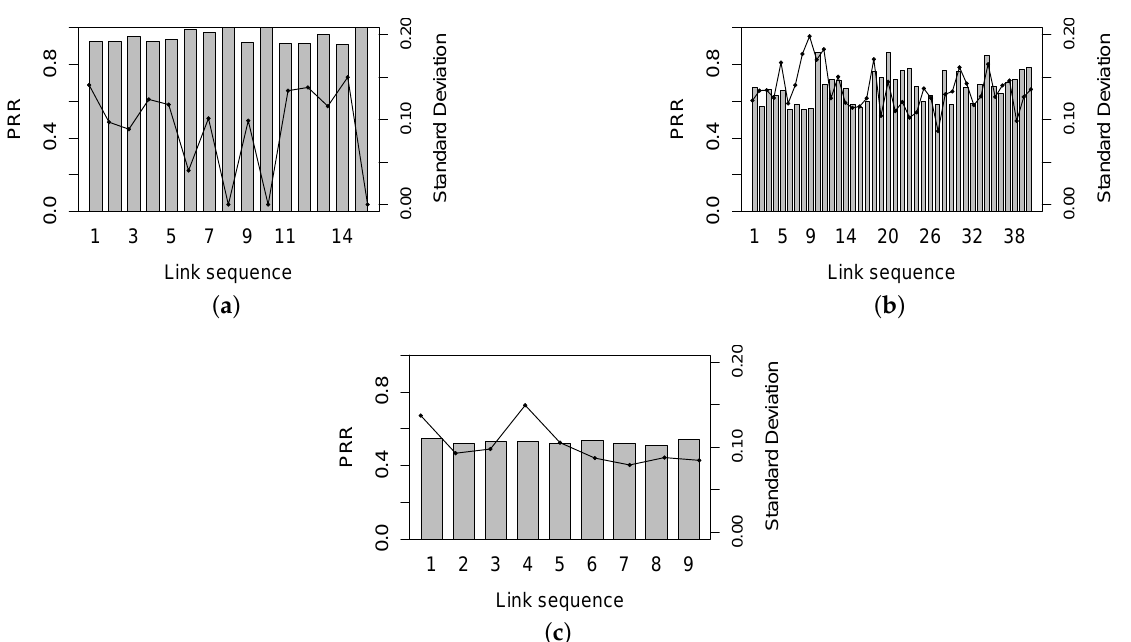
Figure 16. Symmetry variation of links with different link quality. ( a ) Good link; ( b ) Middle link; ( c ) Poor